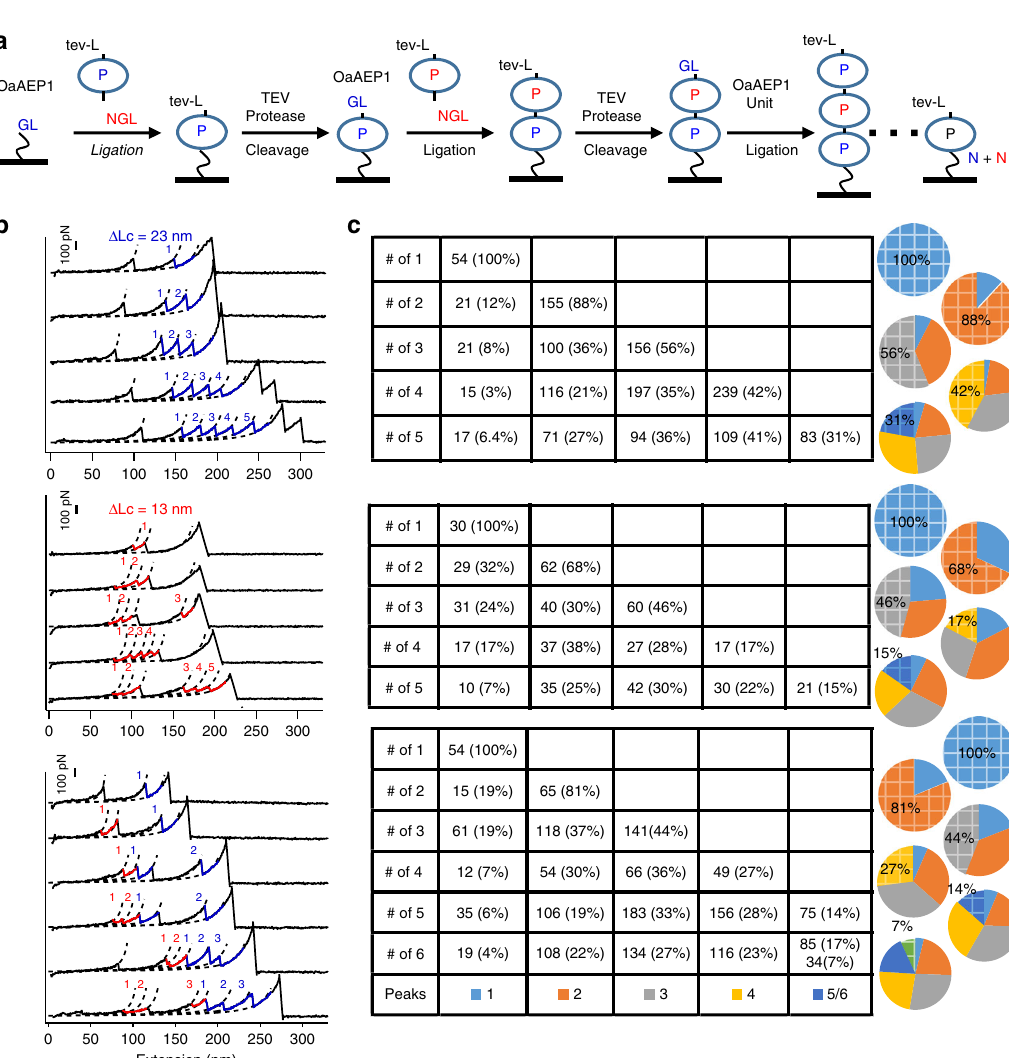
Fig. 6 Stepwise construction of polyproteins with a rationally-controlled sequence. a The schematic of the stepwise, ligation and cleavage procedure to construct sequence-controlled polyprotein on the glass surface. b Representative curves with maximum unfolding peaks from the unfolding experiments of homo-polyprotein (Ub) 5 , top graph, (Rd) 5 , middle graph, and (Ub-Rd) 3, bottom graph, are shown, which were detected during each polymerization step from one to fi ve/six for the same sample. c The statistical analysis of the number of the curve with speci fi c unfolding peaks, corresponding to the left